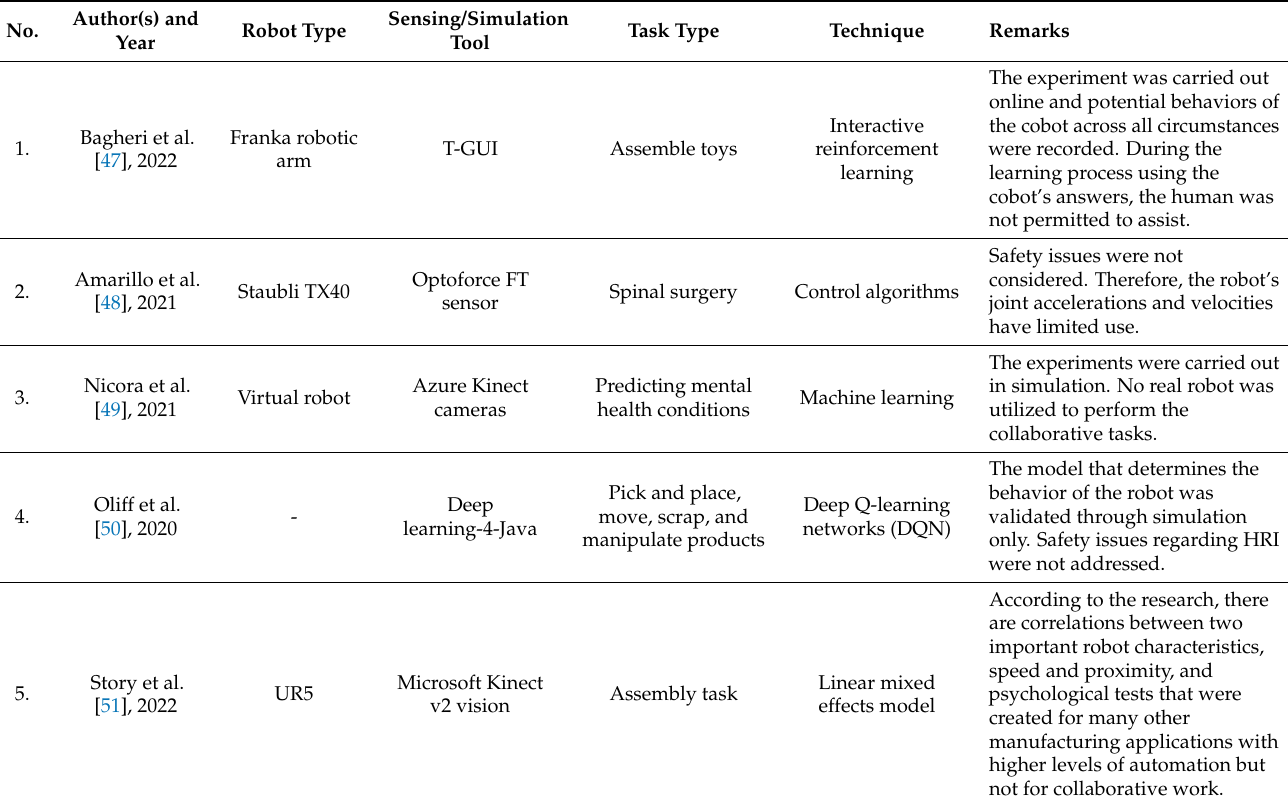
Table 2. Related works with the non-collaborative workspace-type